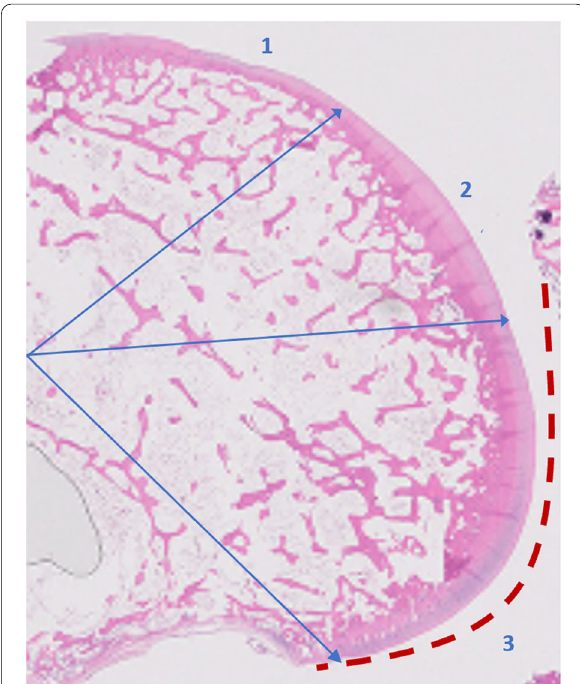
Fig. 3 Sagittal section of medial femoral condyles was divided in three zone of interest (1. anterior, 2. central, and 3. posterior). The red dotted line shows the weight‑bearing area of the medial femoral condyle